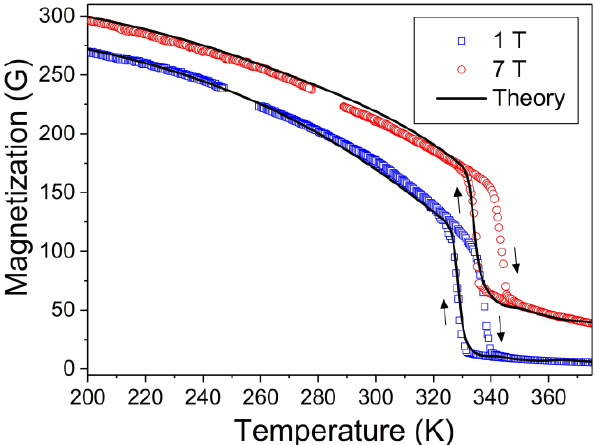
Figure 3. Theoretical temperature dependences of magnetization of Ni 50 Mn 17.5 Ga 25 Cu 7.5 alloy (lines) fitted to experimental ones (symbols) for the field of 1 T and 7 T values.